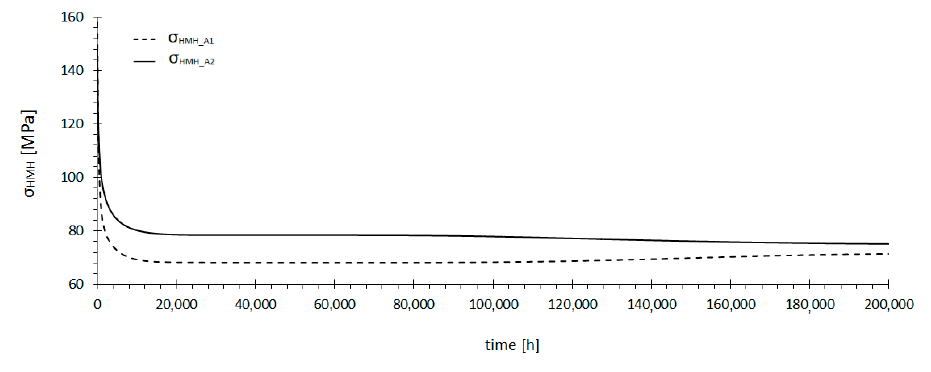
Figure 10. Relaxation of equivalent stress.